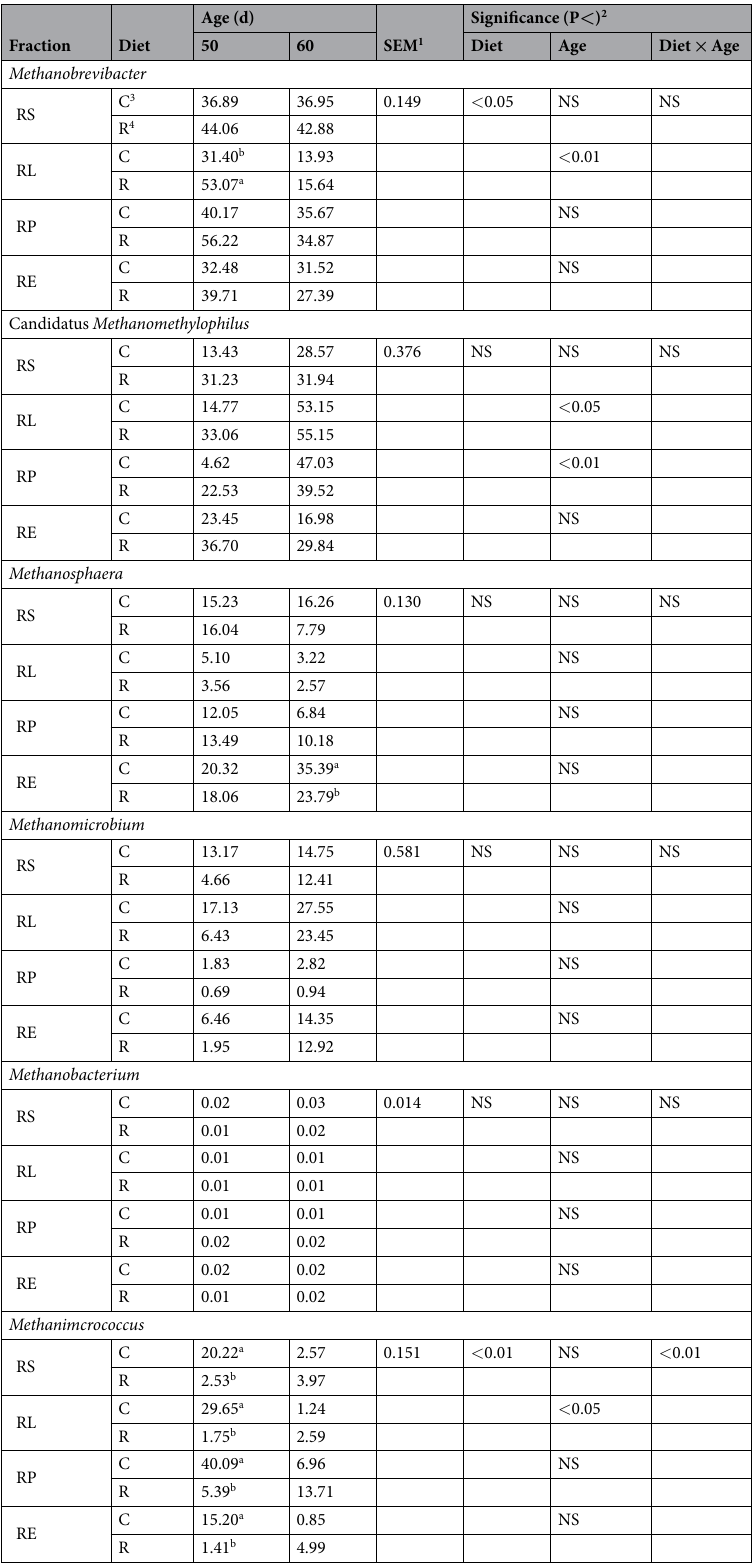
Table 3. Comparison of relative abundance (%) of active methanogenic genera between control diet treatment and rhubarb supplementation treatment a,b . Means within a column for fractions that do not have a common superscript differ (P < 0.05). SEM 1 represents SEM for fraction × age; 2 NS = not significant (P > 0.05); 3 C = control diet treatment; 4 R = rhubarb supplementation